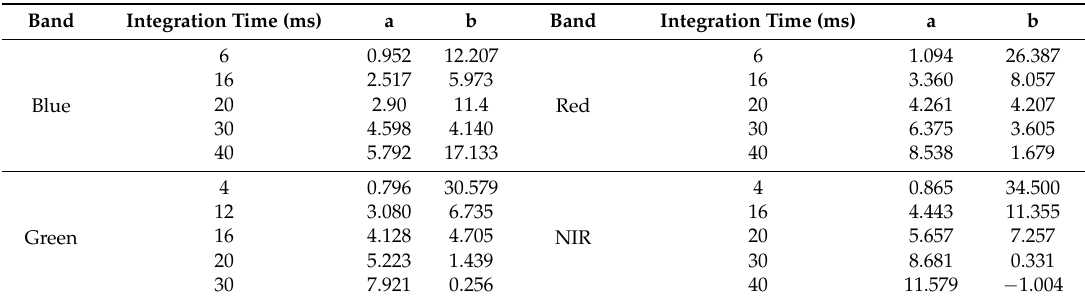
Table 5. Laboratory coefficients in multispectral bands of the GF-4/PMS.